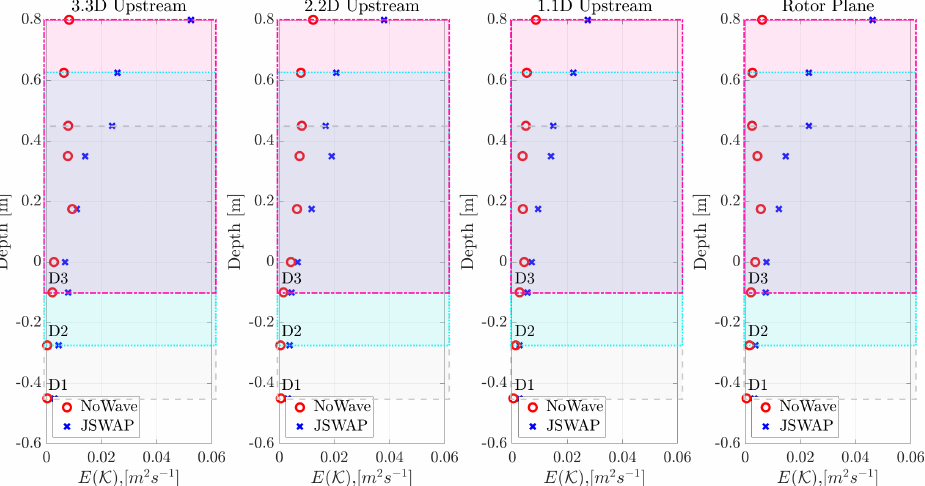
Figure 7. Plots showing the amplitude observed at the average wave frequency at differing depths and upstream LDV positions for the CO and JSP